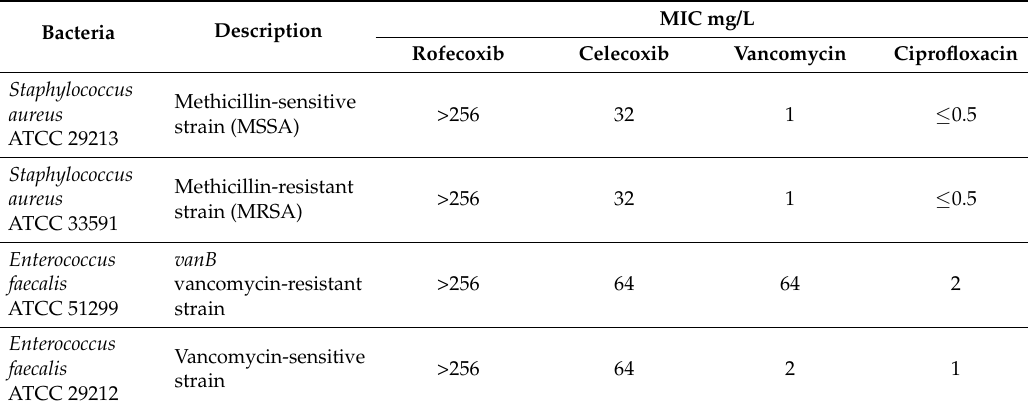
Table 2. Minimum inhibitory concentration (MIC) of celecoxib and rofecoxib against Gram-positive bacteria.